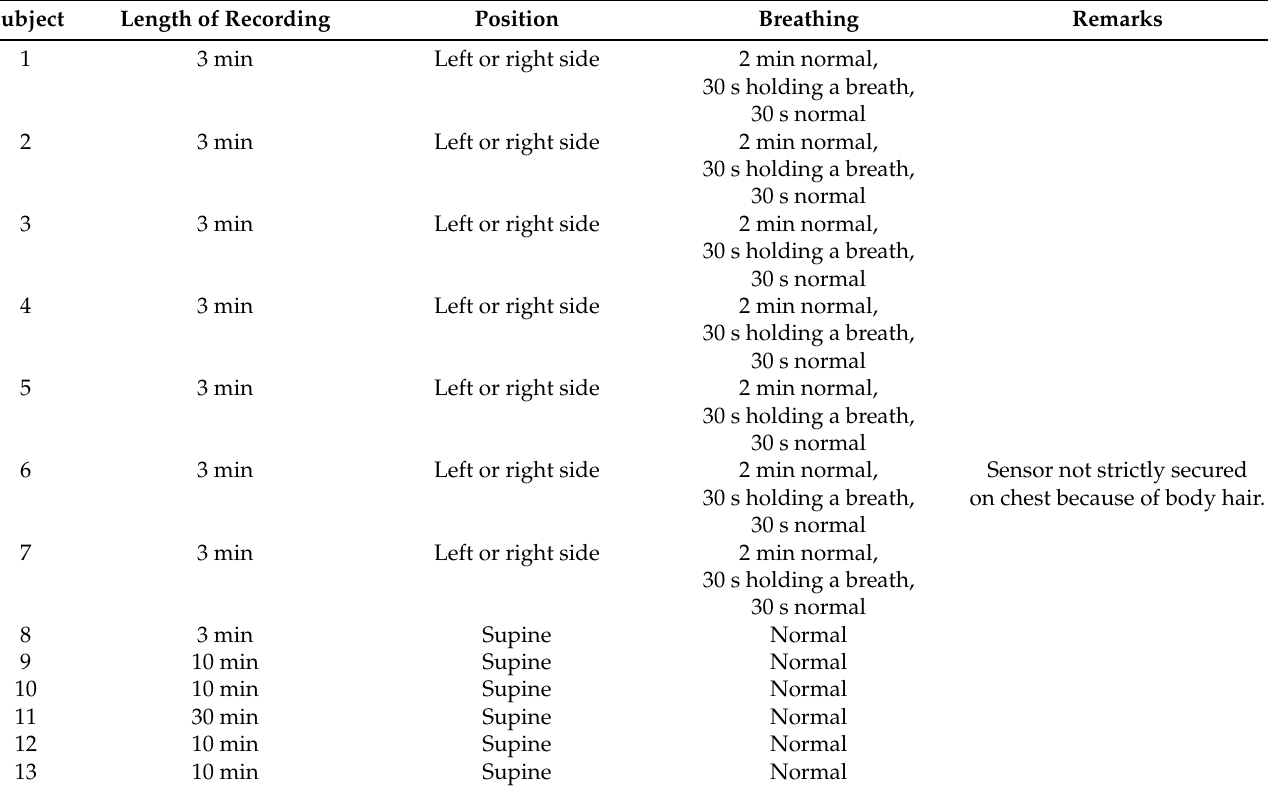
Table A1. Recording description in the “Mechanocardiograms with ECG reference”